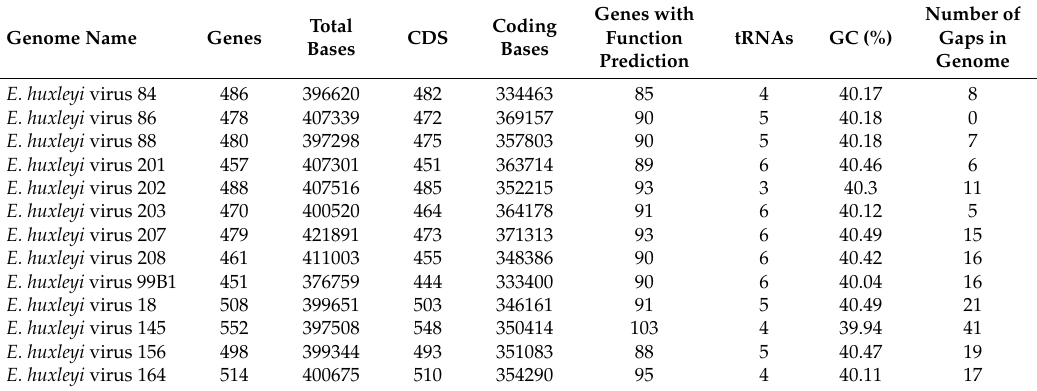
Table 3. Predicted genomic characteristics of sequenced coccolithoviruses. The statistics for each genome were obtained from the annotated ordered genomes uploaded into the Integrated Microbial Genomes—Expert Review (IMG/ER) online genome analysis pipeline [66]. Note that the numbers of genes, bases, coding sequences (CDSs), coding bases and transfer RNAs (tRNAs) here are underestimates (except for EhV-86) due to incomplete genome